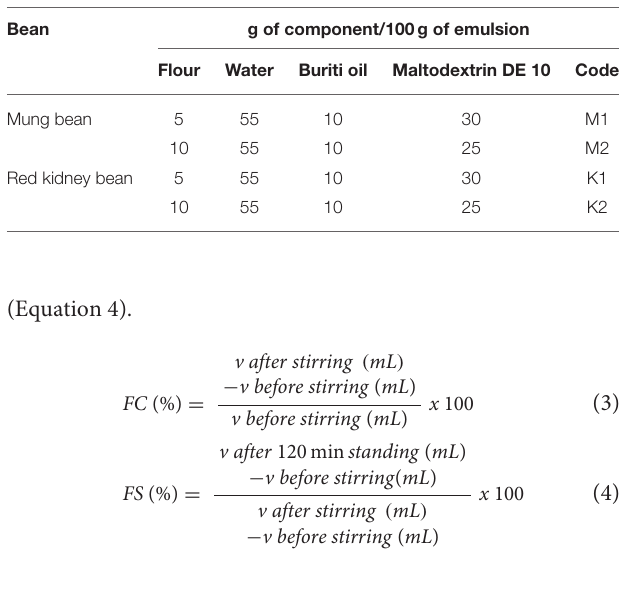
TABLE 1 | Formulation of buriti oil